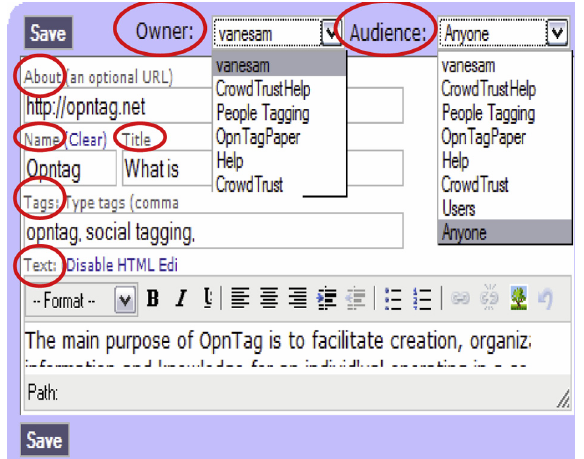
Figure 4. An individual memo in OpnTag with owner and audience list including both the individual and her